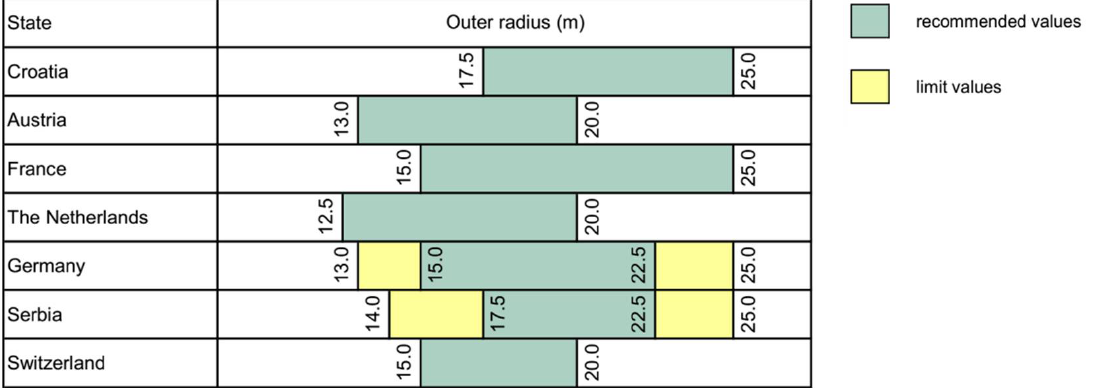
Figure 3. Recommended outer radii for single-lane roundabouts according to [4 – 12].